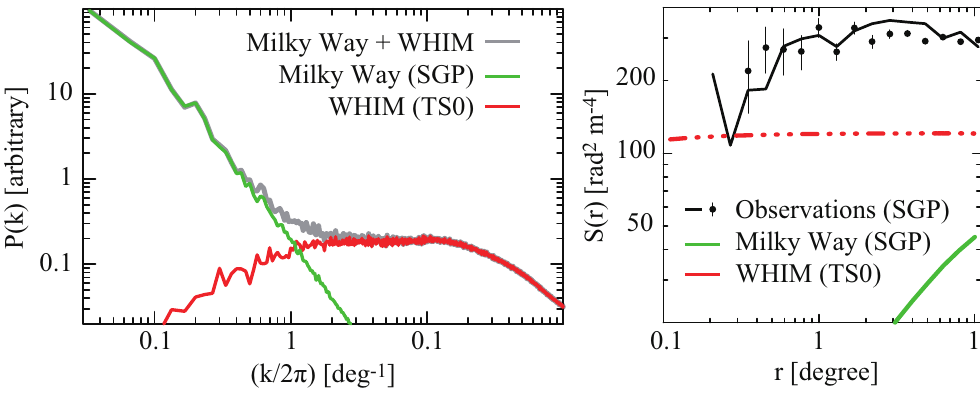
Figure 3. ( Left ) Simulated power spectra of RM for the ISM toward the South Galactic Pole (blue), the warm-hot intergalactic medium (WHIM) (red) and their sum (gray) [42]. ( Right ) The second-order structure functions of RM toward the South Galactic Pole [36,40]. Black marks [55] and line [56] are observational